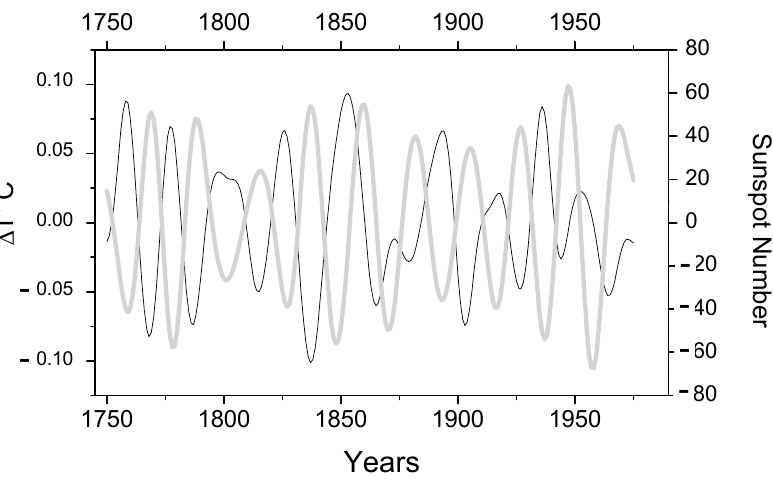
Figure 2. Time series wavelet filtered using Hale (18.1–25.3 years) scale band. Black line—temperature at gridpoint (60 ◦ N, 30 ◦ E) [11], thick grey line—the record S 22 shifted by 1 year.